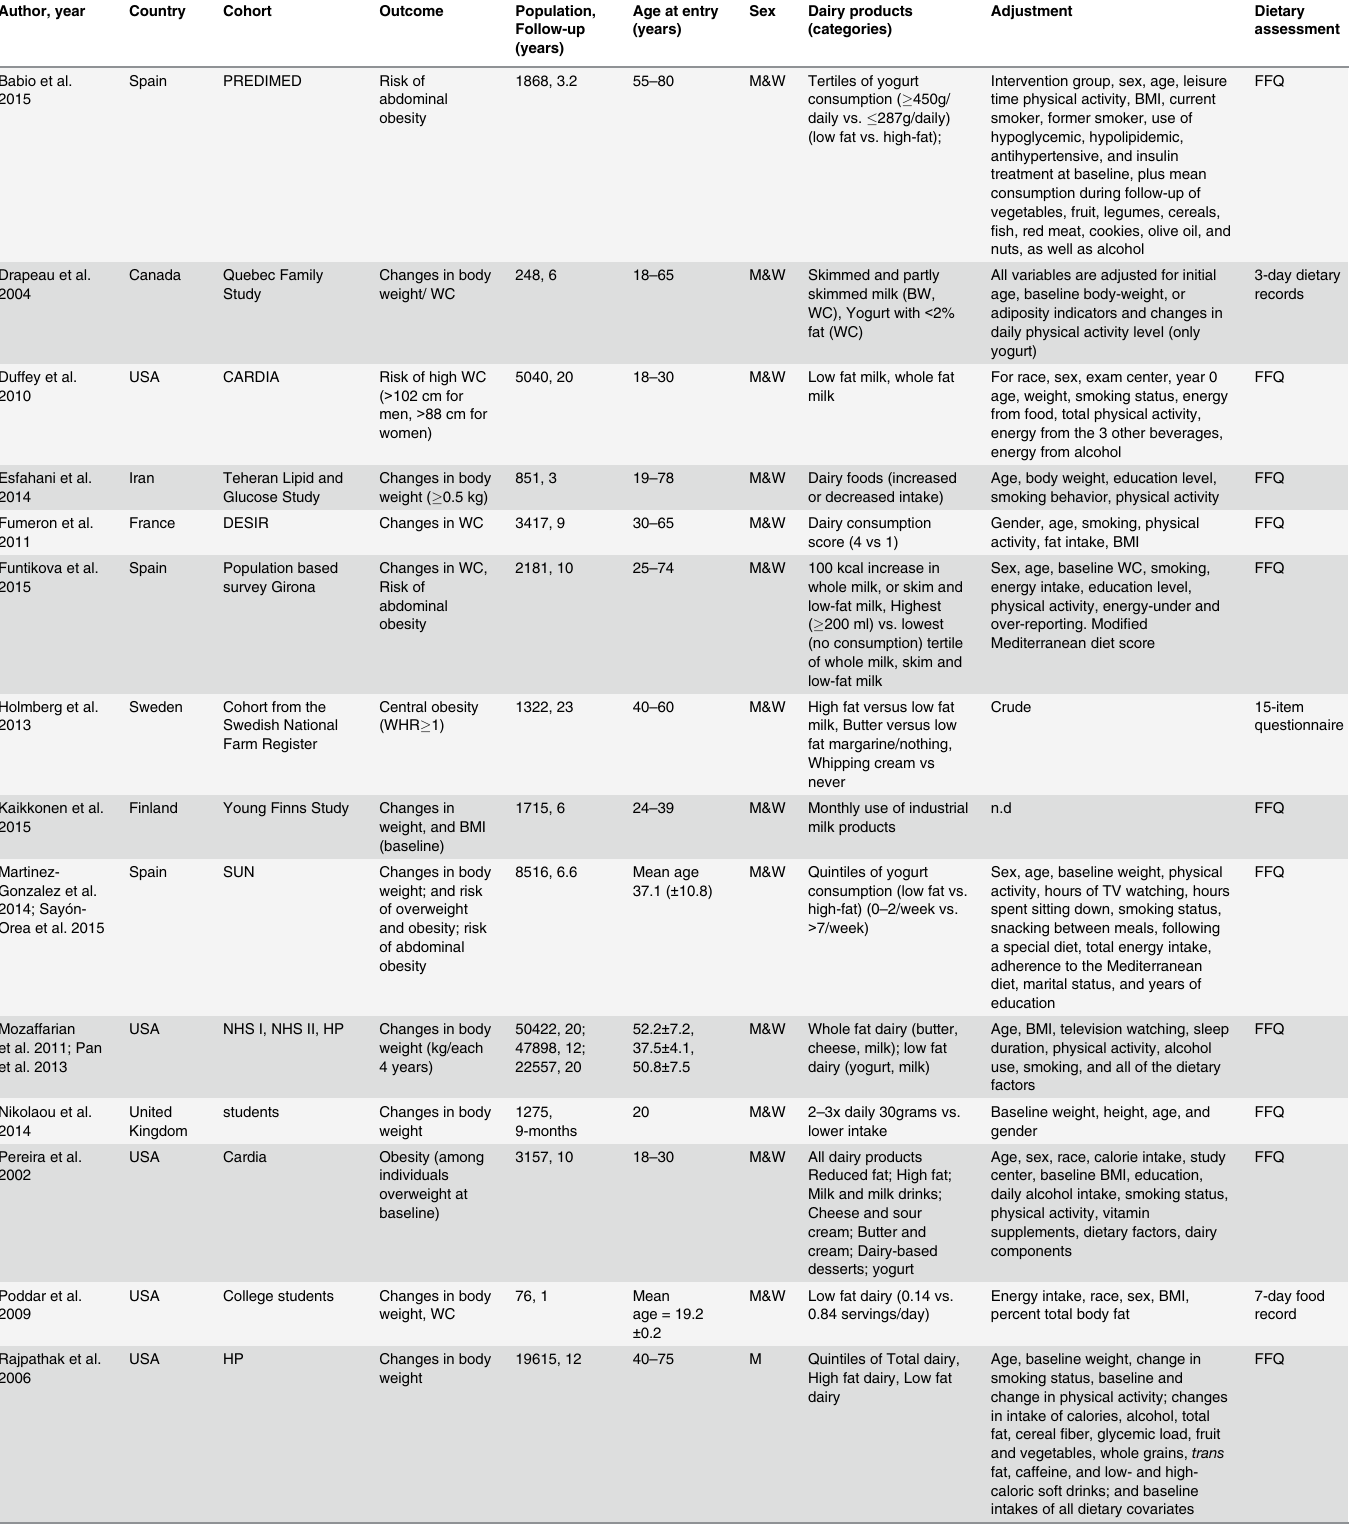
Table 1. Characteristics of prospective observational studies included in the qualitative systematic review or quantitative